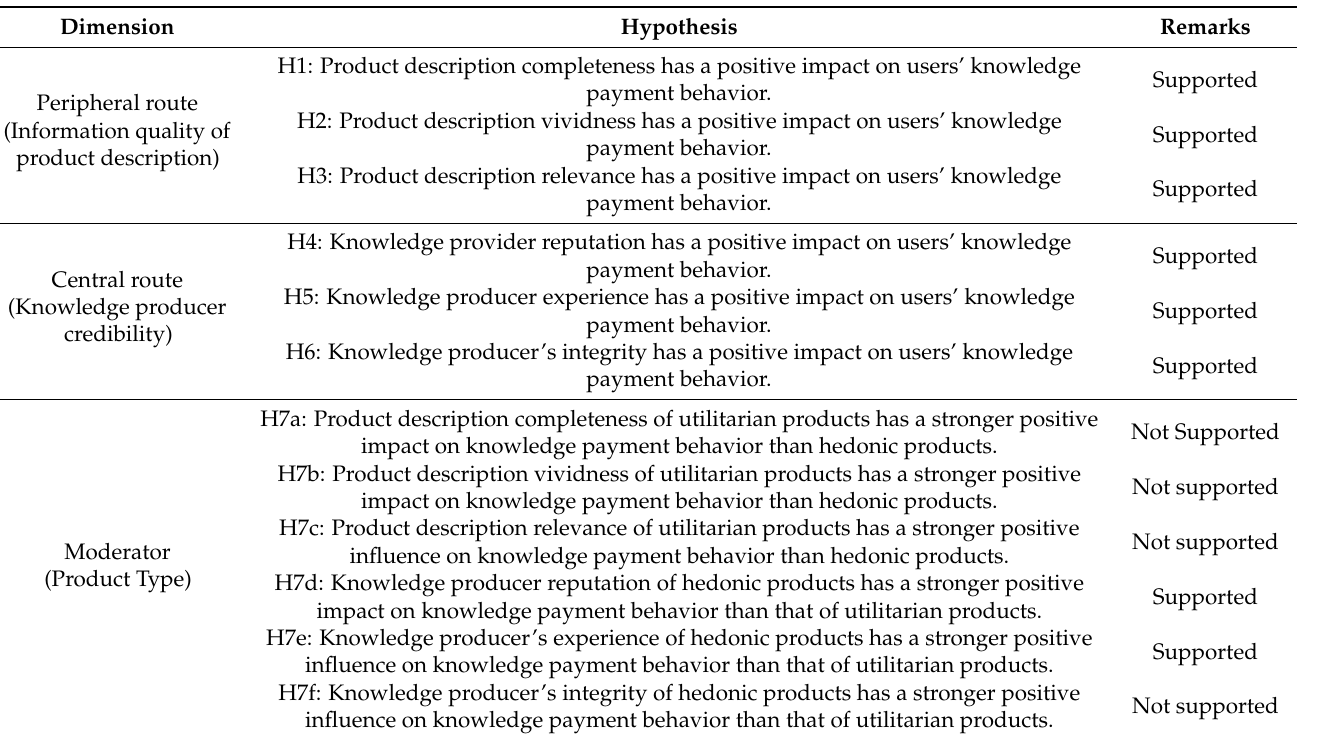
Table 7. Hypotheses testing